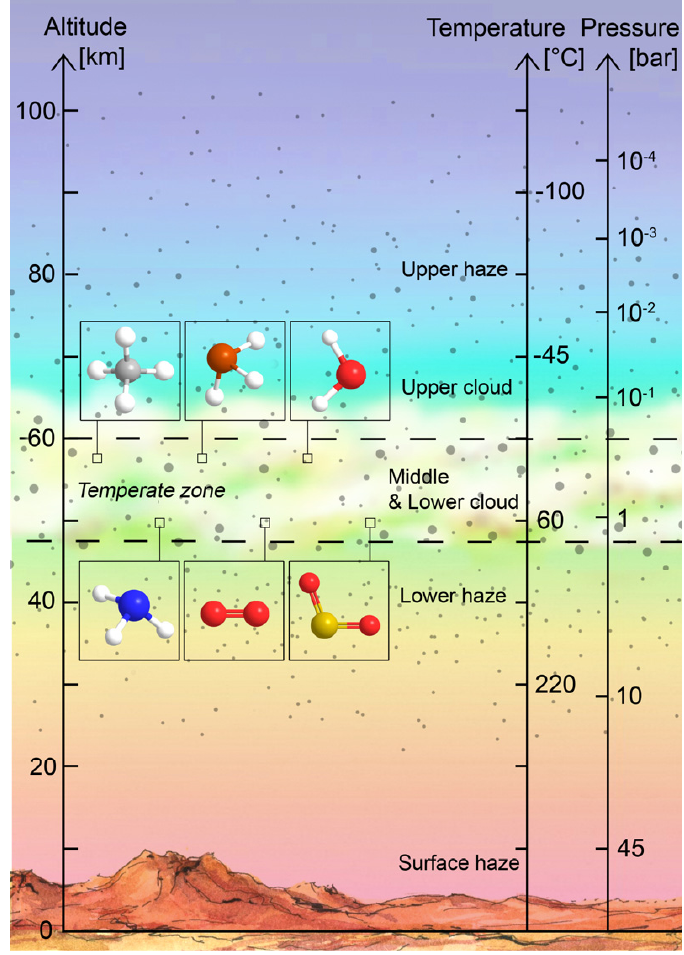
Figure 1. Schematic of Venus’ atmosphere. The cloud cover on Venus is permanent, continuous, and vertically extensive. The middle and lower cloud layers have temperatures suitable for life. Selected molecules relevant to habitability or life and with unexplained presence or vertical abundances are shown. Atom colors are as follows: H = white; C = grey; P = orange; O = red; N = blue; S = yellow. Figure adapted from [5].